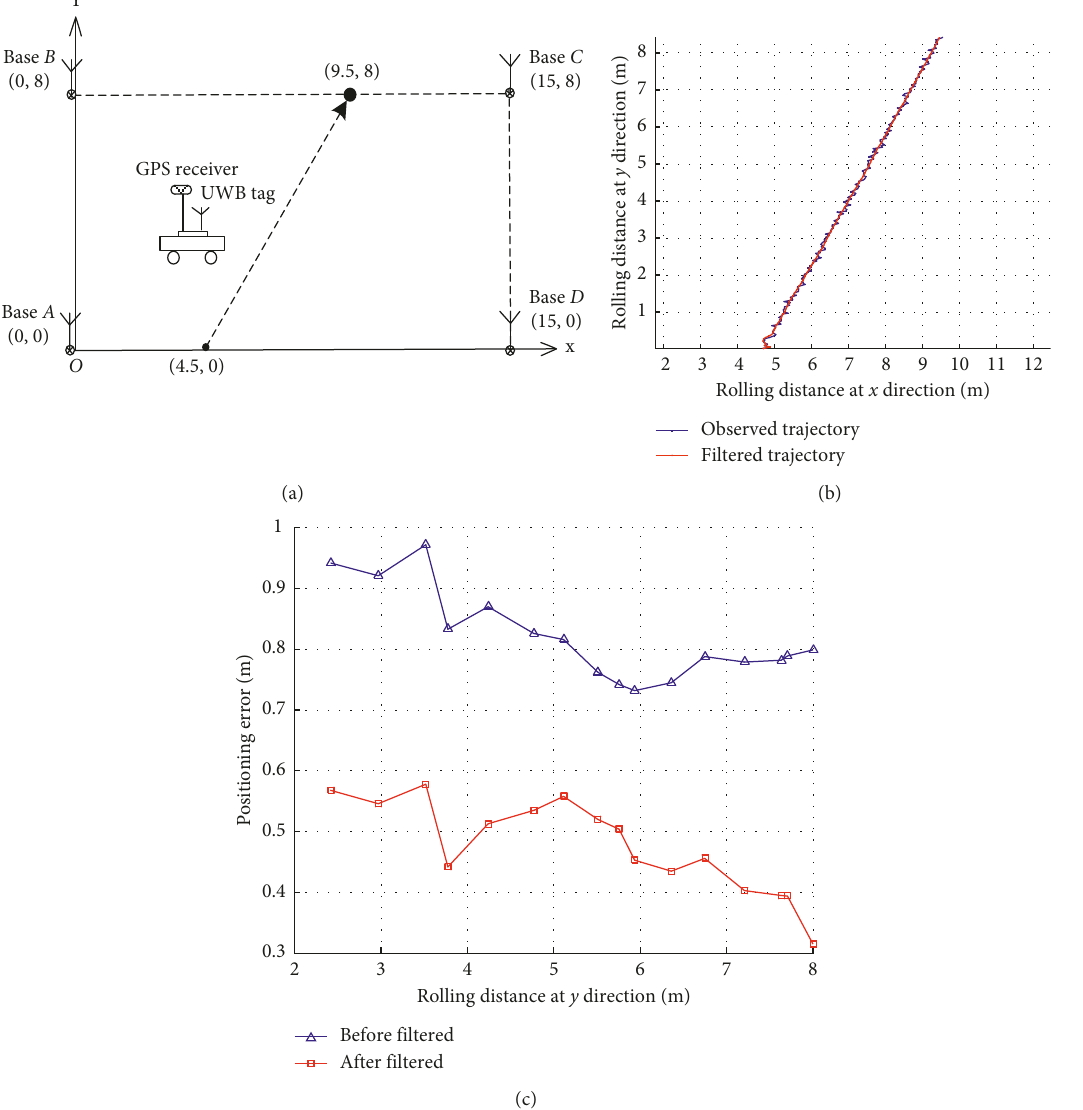
Figure 4: Diagram and results of collaborative positioning experiments. (a) Schematic diagram of positioning experiments. (b) Results of positioning experiments. (c) Accuracy analysis of positioning experiments.